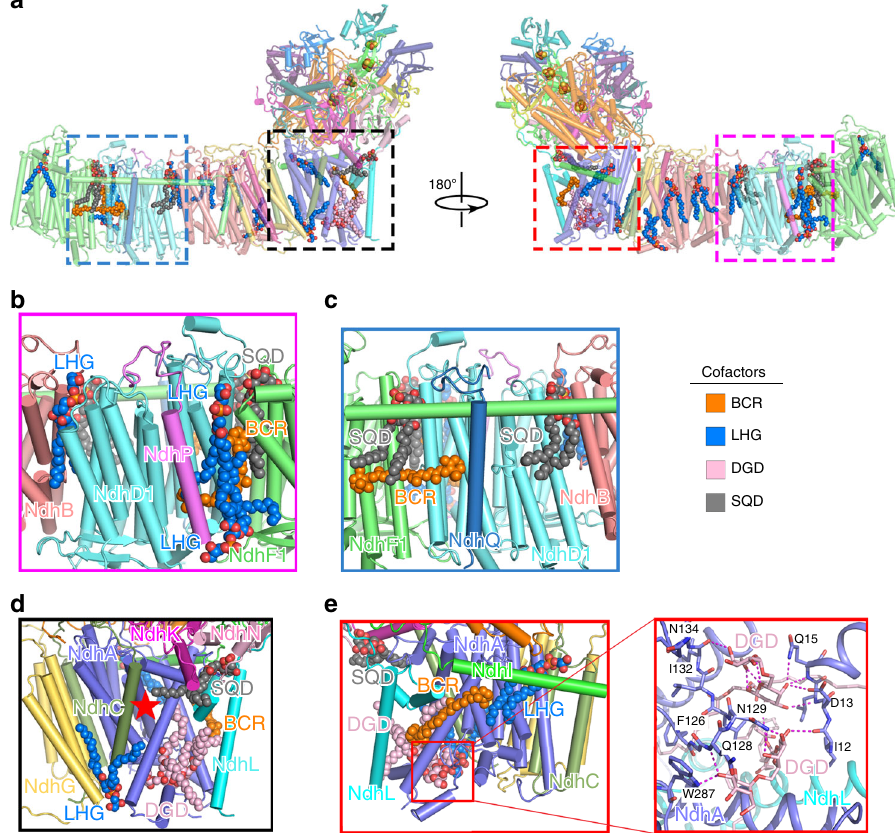
Fig. 2 Hydrophobic cofactors identi fi ed in the Fd-NDH-1L complex structure. a Two side views of the Fd-NDH-1L complex with cofactors shown as spheres, colored as in Fig. 1b. Cofactors are color-coded and the scheme is shown below. BCR β -carotene, LHG dipalmitoylphosphatidylglycerol, SQD sulfoquinovosyldiacylglycerol, DGD digalactosyldiacylglycerol. b , c Close-up views of cofactor locations at the interfaces between NdhD1 and NdhP, NdhF1, and NdhB ( b ) and between NdhD1 and NdhQ, NdhF1, and NdhB ( c ). d , e Close-up views of cofactor locations in the heel of the complex around NdhA and NdhL. Red star denotes the entrance to the PQ-binding cavity ( d ). Interactions between DGD and NdhA/NdhL in the box region are enlarged in the inset shown below ( e ). Dashed magenta lines denote the intermolecular hydrogen-bonding